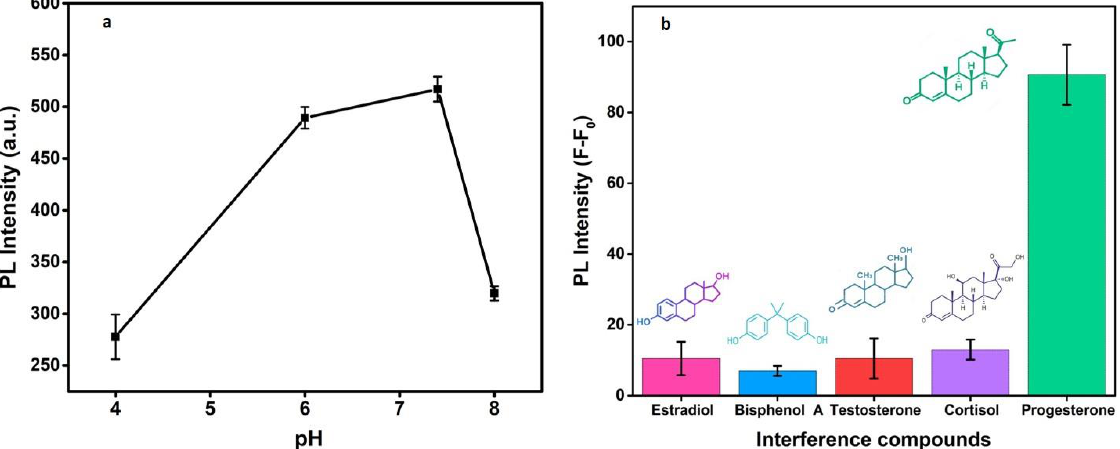
Figure 8. pH effect on the fluorescence of proposed PGN biosensor ( a ) and change in PL intensity with different interference compounds ( b ).